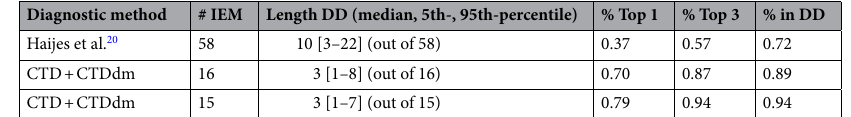
Table 3. Accuracy of diagnostic rankings across 188 plasma samples with known disease. A differential diagnosis list (DD) is a ranked list of potential “candidate” diagnoses for each individual. Diagnoses were added to the DD if individual sample data meet a given threshold defined by each diagnostic method. Rankings were determined and compared for both a rule-based method described in Haijes et al. 20 and for our combined network (CTD + CTDdm) approach. IEMs inborn errors of metabolism, DD differential diagnosis